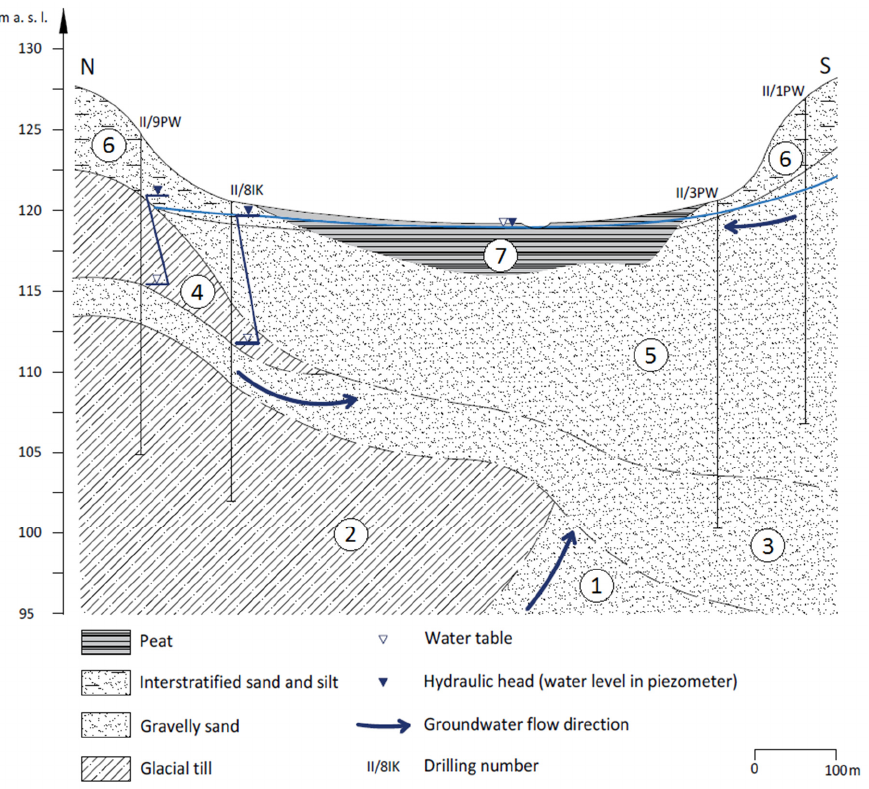
Figure 1. Geological cross-section through the Upper Biebrza ice-marginal valley (Vistula river catchment, NE Poland). Stratigraphy and genetic type of deposits: 1—Saalian (Odra) fluvioglacial sediments; 2—Saalian (Odra) glacial sediments 3—Saalian (Warta) fluvioglacial sediments; 4—Saalian (Warta) glacial sediments; 5—Vistulian (pre-LGM) fluvioglacial sediments; 6—Vistulian (post-LGM) kame terrace; 7—Holocene peat.